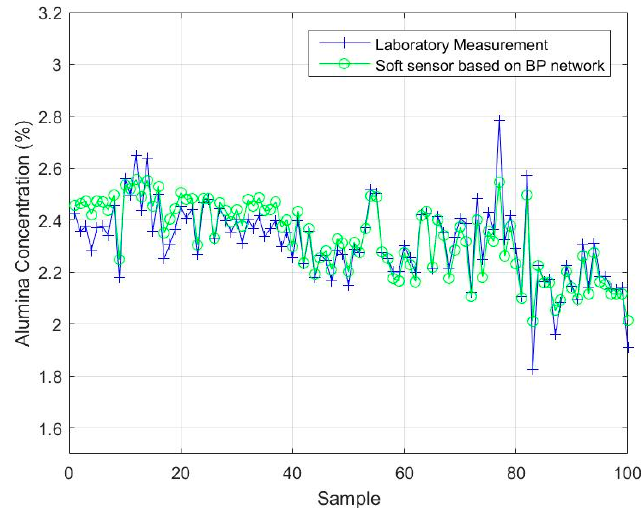
Figure 6. The estimated values of the soft sensor based on a backpropagation (BP) network compared with actual laboratory measurements.